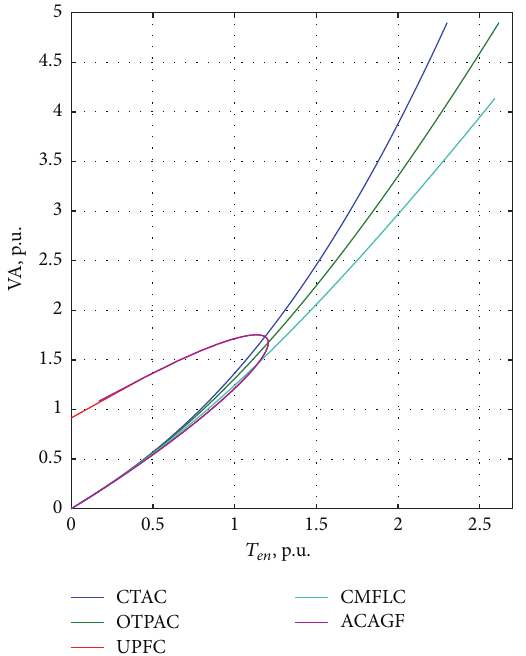
Figure 11: VA requirement for five different control strategies as a function of normalized torque.